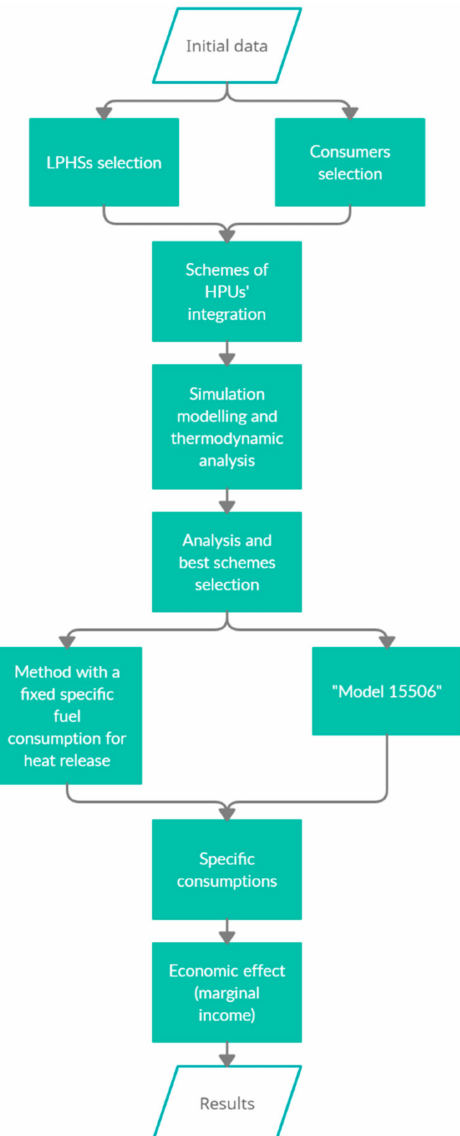
Figure 1. Flowchart of the methodology for analyzing the possibility of using heat pump units (HPUs) in the technological scheme of combined-cycle gas turbines